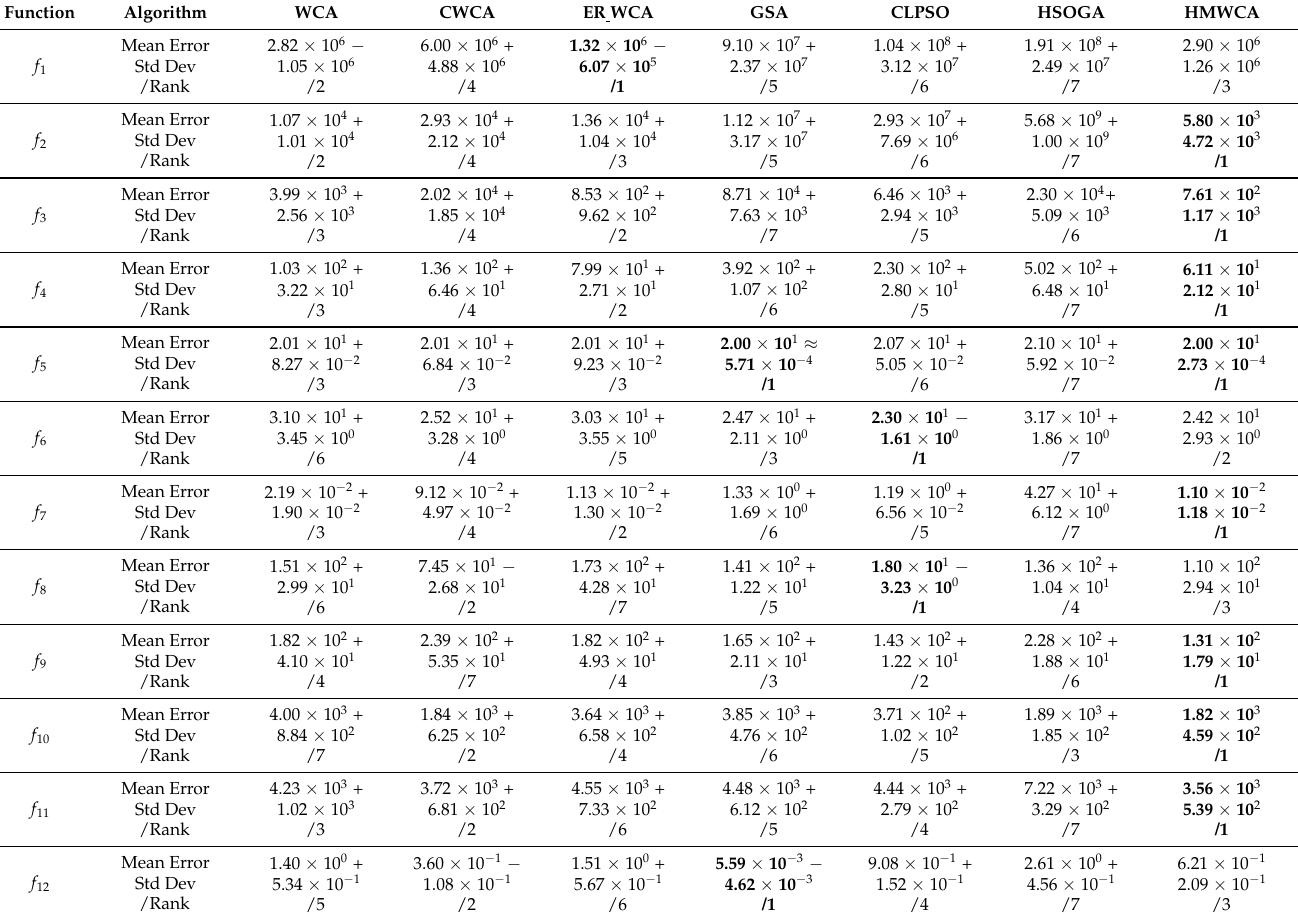
Table 4. Experimental results of the HMWCA and six well-known algorithms on the CEC 2014 functions with D =